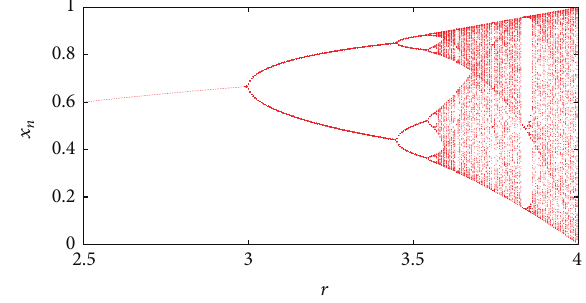
Figure 2: Logistic map bifurcation diagram.